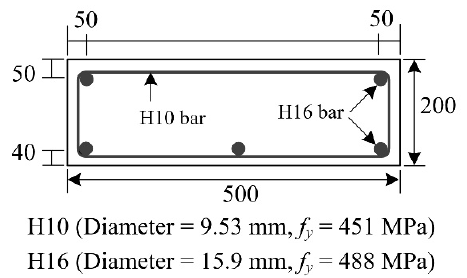
Figure 7. Cross-sectional dimensions and reinforcement details (unit: mm).